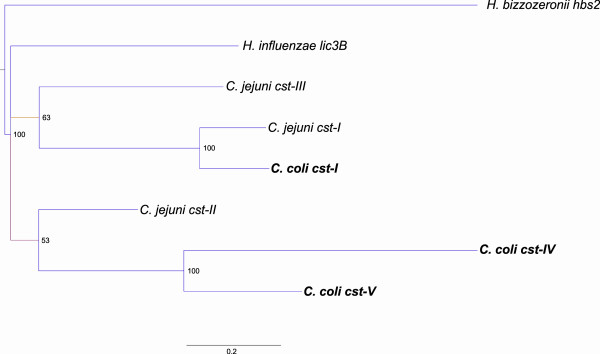
Bayesian phylogeny of GT42 sialyltransferases indicating relatedness of C. jejuni and C. coli sialyltransferases.C. coli cst-I is found in the capsule (CPS) locus of C. coli clade 3 strains and is an ortholog of C. jejuni cst-I. C. coli cst-IV is found in the lipooligosaccharide (LOS) locus of C. coli clade 1 strains and C. coli cst-V is found in the LOS locus of C. coli clade 3 strains.